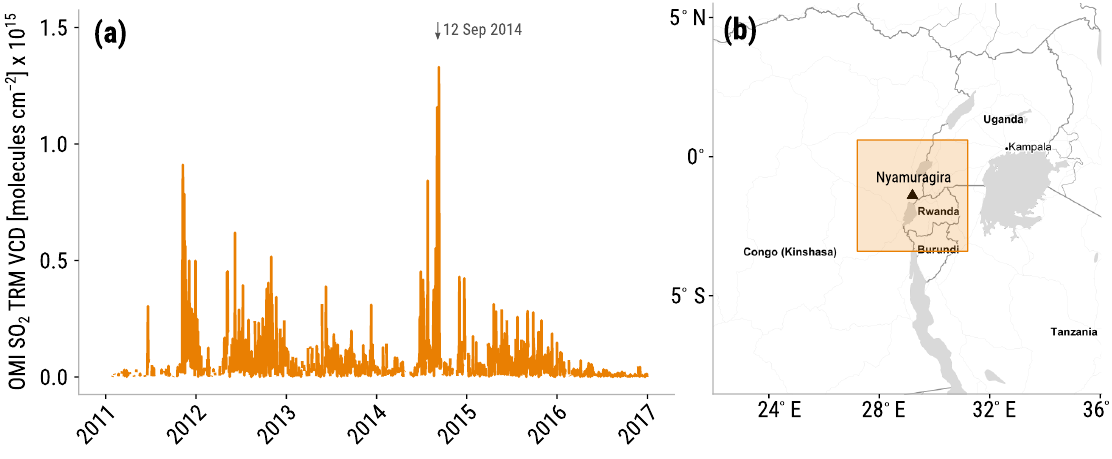
Figure 3. (a) Time series of daily-averaged OMI SO 2 TRM VCD observations corresponding to the averages over the area delimited by 27.2 ◦ E, 3.4 ◦ S, 31.2 ◦ E, and 0.6 ◦ N. (b) Map of eastern Africa showing the averaging area (orange square). The location of Nyamuragira is represented by a black triangle.